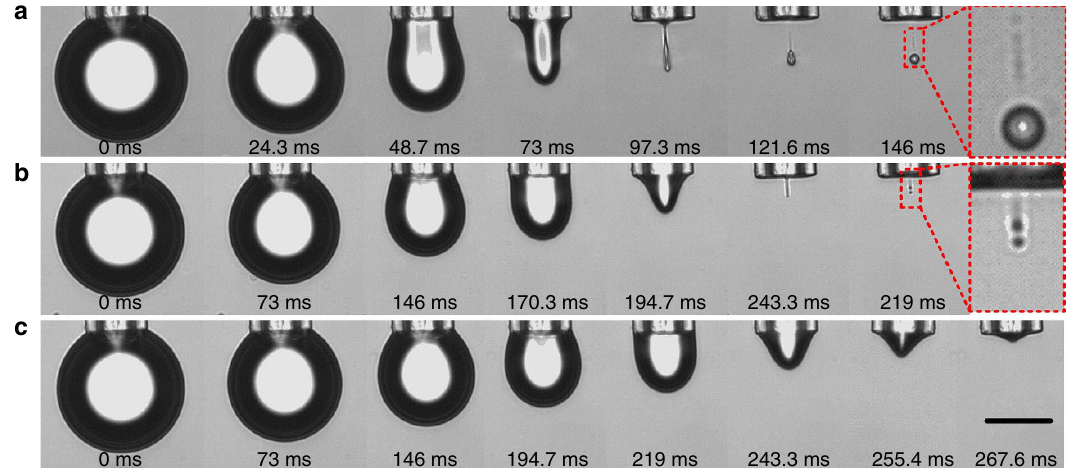
Figure 1 | Three regimes of droplet formation. Droplet formation at various Q ( a ) 7.2nls (cid:2) 1 (regime A, one main droplet), ( b ) 2.46nls (cid:2) 1 (regime B, multiple droplets of similar sizes) and ( c ) 1.96nls (cid:2) 1 (regime C, no droplet formation). The outer and inner radii of the nozzle are 23 and 15 m m, respectively, V m ¼ 0.52nl, s 12 ¼ 9mNm (cid:2) 1 . Scale bar, 50 m